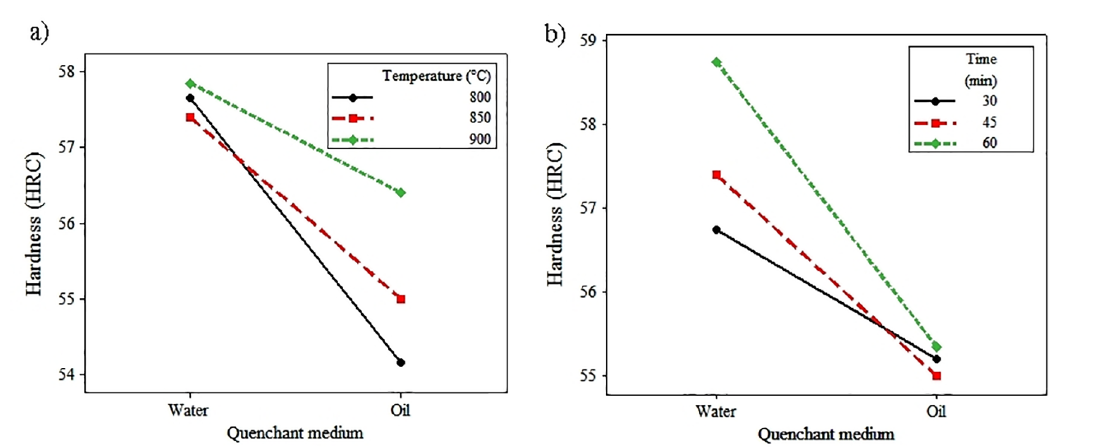
Figure 5. Interaction between: a) quenchant and temperature; b) quenchant and time for